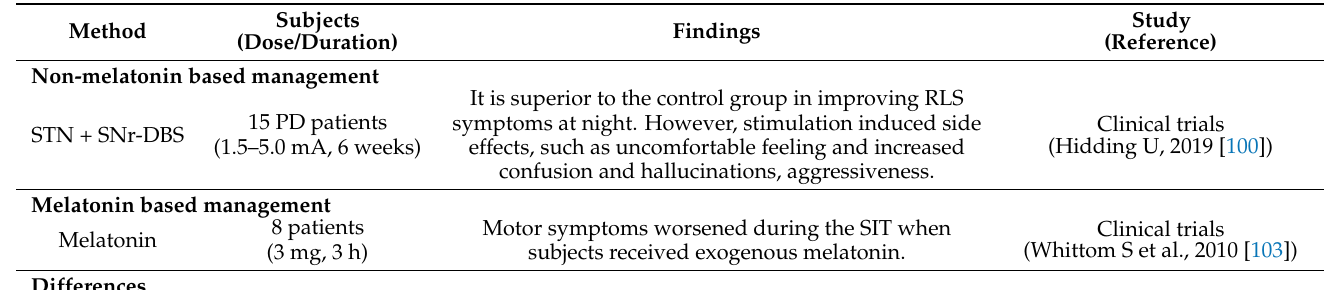
Table 5. Restless legs syndrome and periodic limb movement in Parkinson’s disease and their management supported by randomized controlled